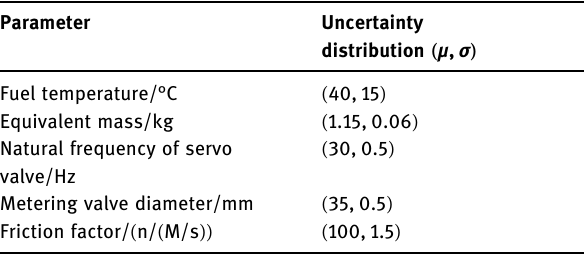
Table 1: Model uncertainty